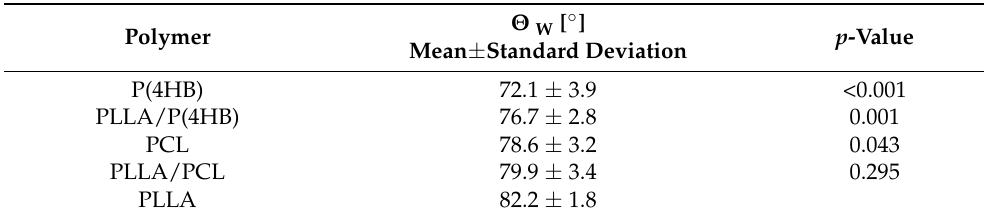
Table 1. Contact angle of water ( Θ W ) on polymers as per sessile drop static measurement. Statistically significant differences to the basic material PLLA were analyzed by